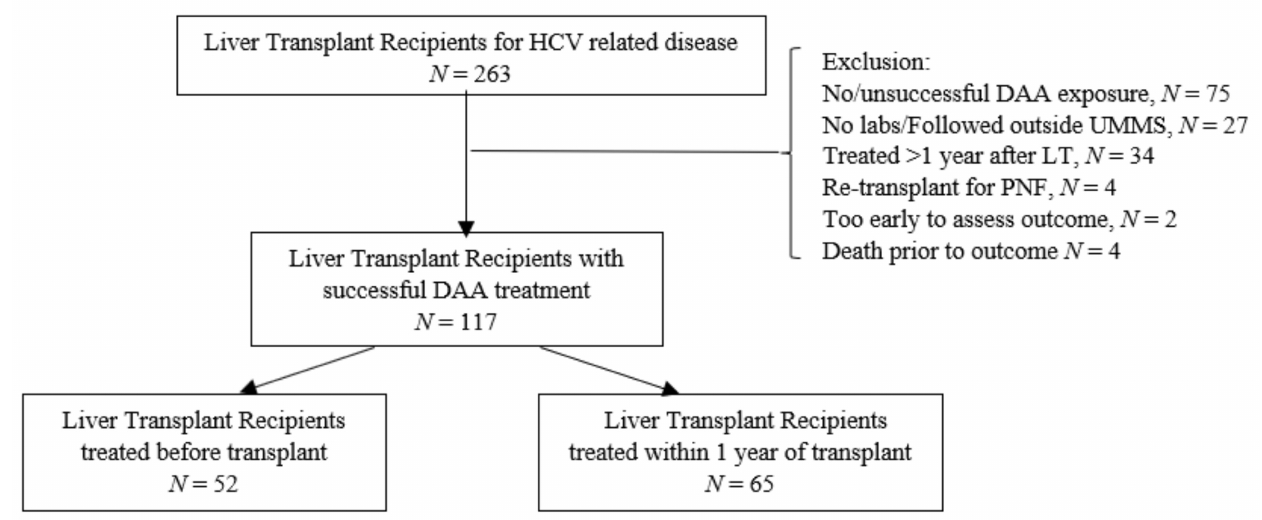
Figure 1. Liver transplant recipient study selection. From the 263 potentially eligible patients, 117 met the inclusion criteria. Patients were divided into two groups for analysis: liver transplant recipients treated before transplant, N = 52 and liver transplant recipients treated within one year of transplant, N = 65. HCV, hepatitis C virus; DAA, direct acting antiviral therapy; UMMS, University of Maryland Medical System; PNF, primary